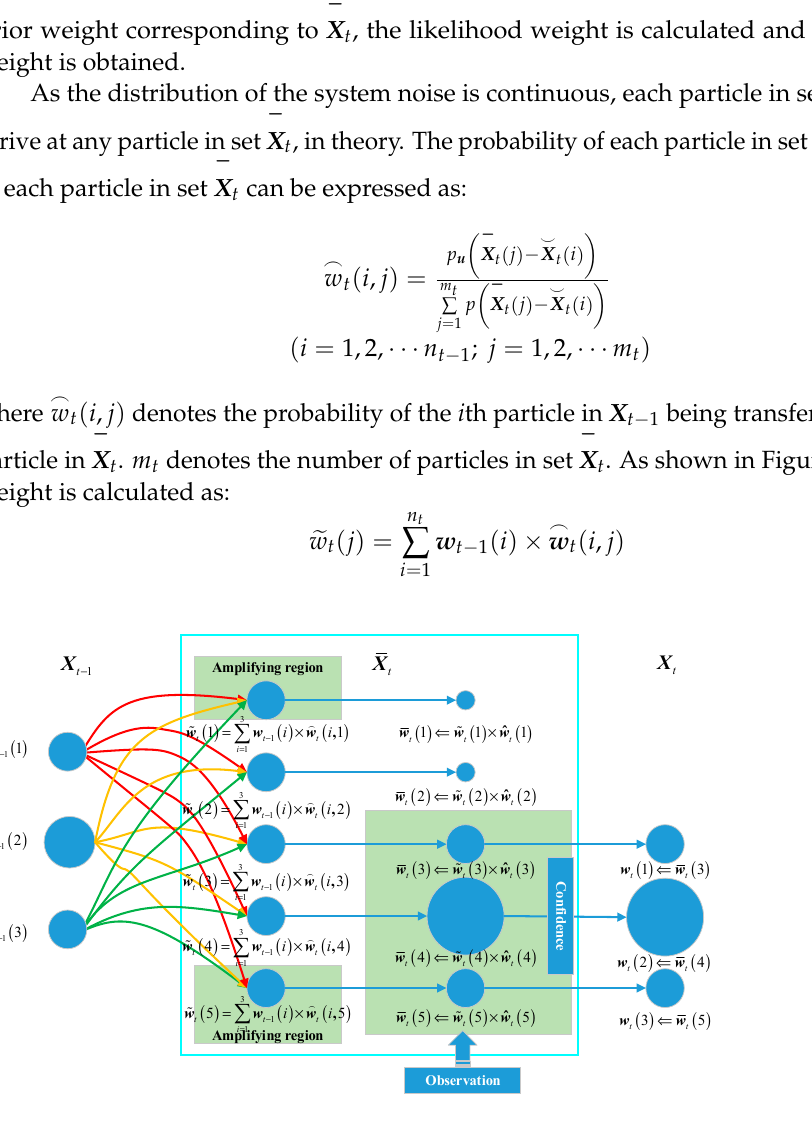
Figure 8. Schematic diagram of particle and weight changes.